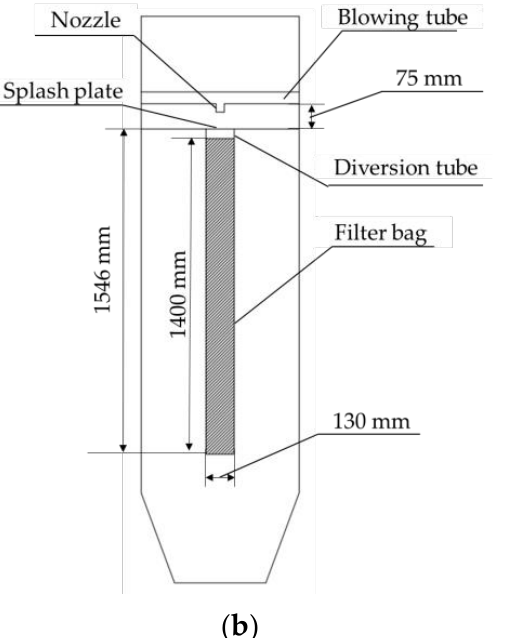
Figure 1. Dust removal model of dust remover. ( a ) Three-dimensional geometric model drawing; ( b ) Schematic diagram of the structure.